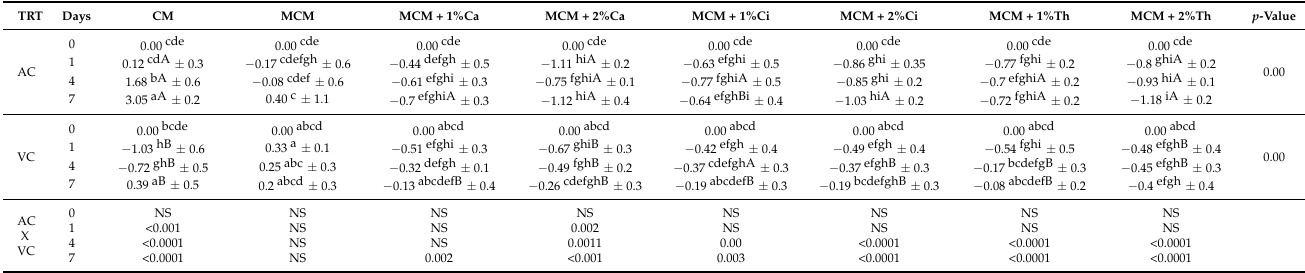
a–i Different letters indicate significant differences between days and the treatments ( p < 0.05). A,B Populations under the same treatments in each column followed by different letters are significantly different ( p < 0.05) —Initial quantity (N0) of camel meat (CM) in aerobic and vacuum packaging: 5.4 ± 0.2 and 5.0 ± 0.5 log CFU/g; marinated camel meat (MCM) in aerobic and vacuum packaging: 5.1 ± 0.4 and 6.0 ± 0.2 CFU/g.—MCM + 1% Ca: marinated camel meat and 1% carvacrol; MCM + 2% Ca: marinated camel meat and 2% carvacrol;